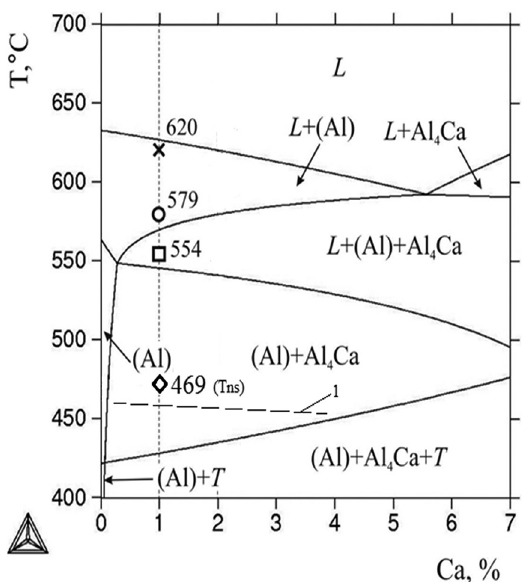
Figure 6. Calculated vertical section Al-3.5%Mg-9%Zn-Ca and experimental data from DSC analysis (1 - calculated non-equilibrium solidus).